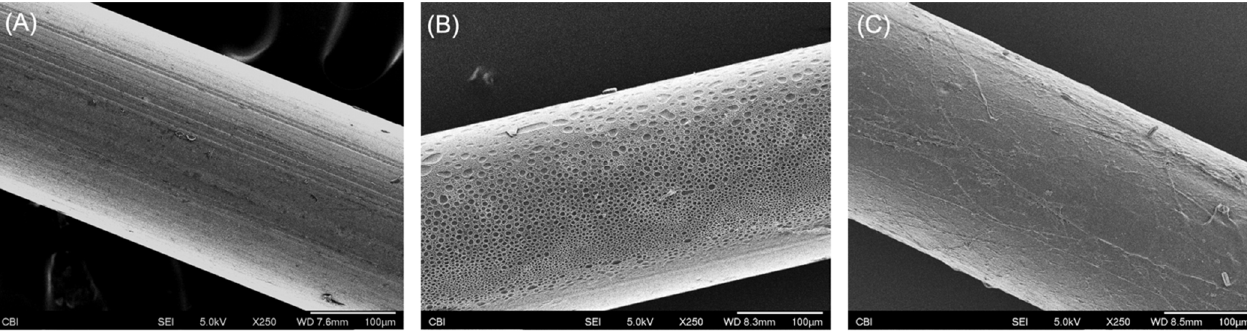
Figure 2. Iron wire samples treated with ( A ) phytic acid – Zn, ( B ) phytic acid – Zn + PCUU dip coating, and ( C ) phytic acid – Zn + PCUU dip and spray coating.